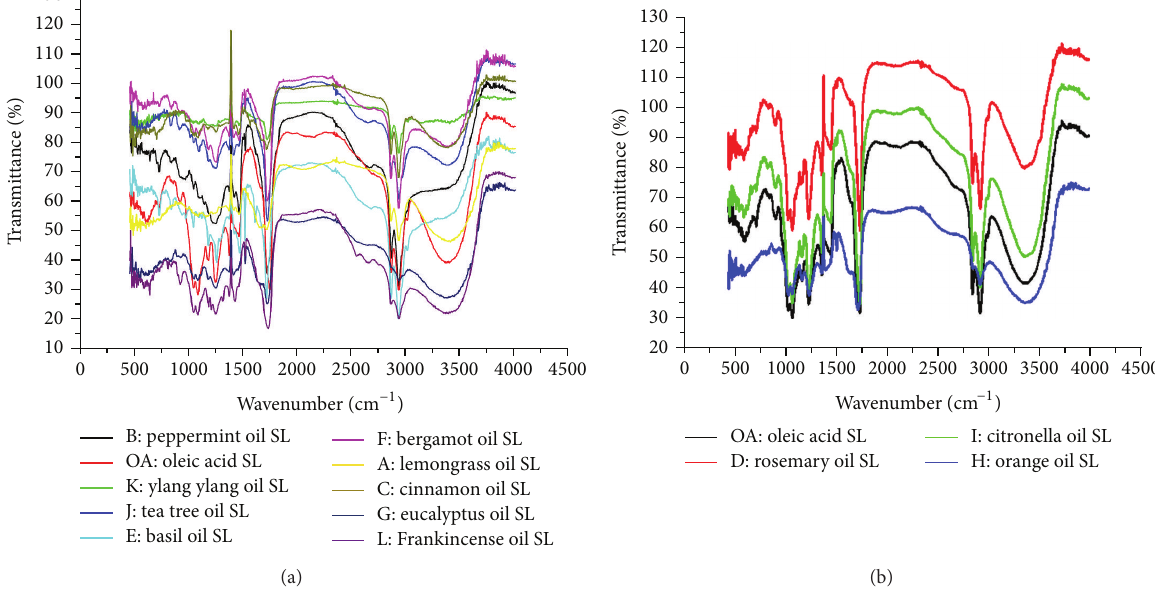
Figure 3: (a) FTIR analysis of the synthesized EOSLs along with OASL. (b) FTIR spectra of EOSLs with composition similar to